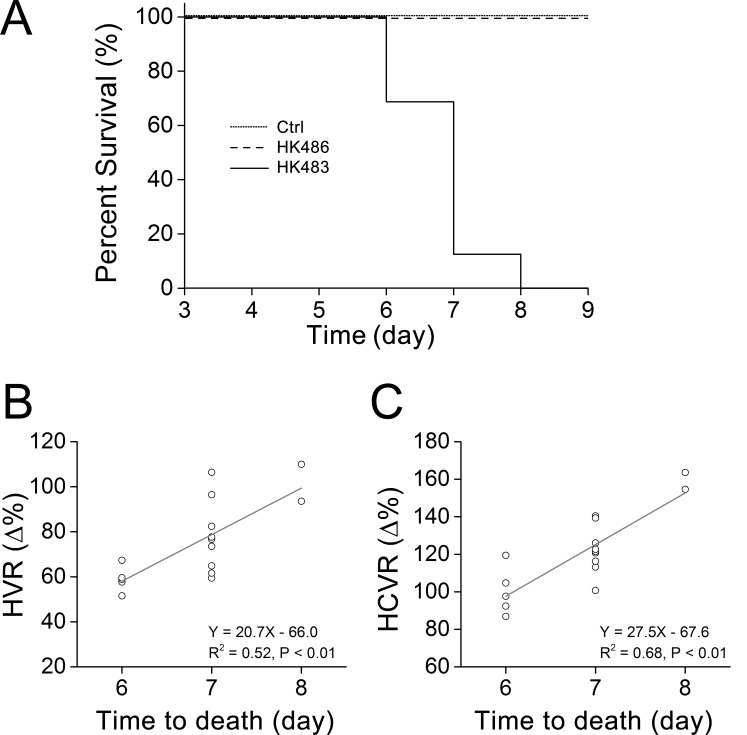
The time to death after viral infection and its correlation with the severity of HVR/HCVR depression.A: Mortality of Ctrl, HK483, and HK486 mice over the infection period (up to 9 dpi). B and C: HVR and HCVR of individual HK483 mice were plotted against their corresponding death day (at 6, 7, and 8 dpi). Mean ± SE. A: n = 6, 15, and 7 for Ctrl, HK483 and HK486 mice, respectively. B and C: n = 15 HK483 mice. HK483 but not HK486 viral infection led to death at 6–8 dpi and the mice with the larger decrement in HVR or HCVR died earlier.